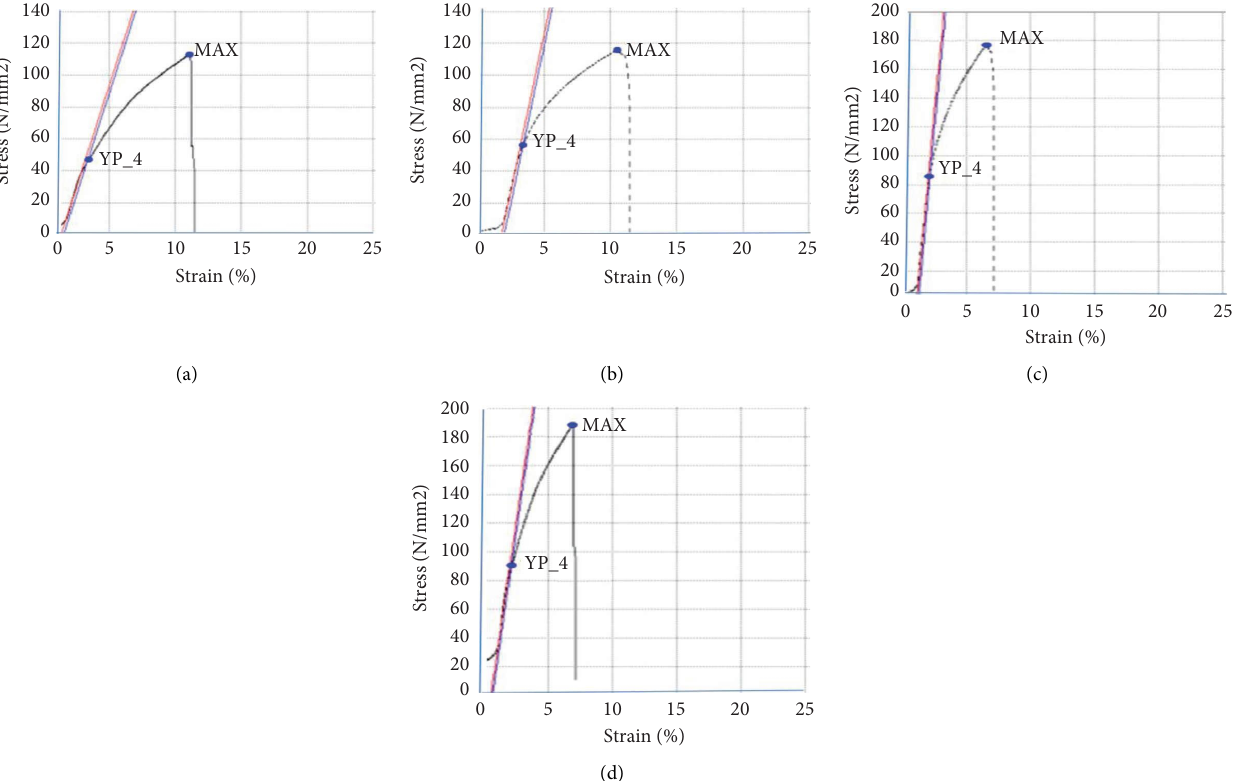
Figure 9: Stress vs. strain of nanocomposites for (a) specimen M1, (b) specimen M1, (c) specimen M1, and (d) specimen